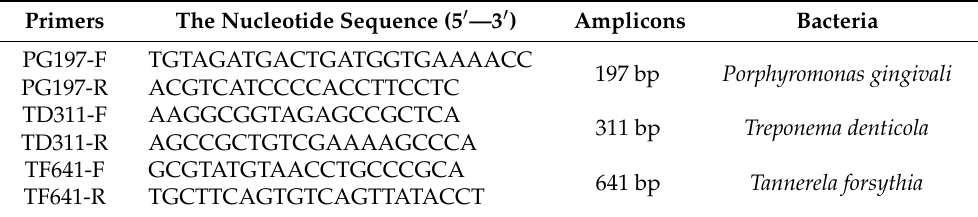
Table 1. The primers of Porphyromonas gingivalis, Treponema denticola, and Tannerela forsythia [14–16].